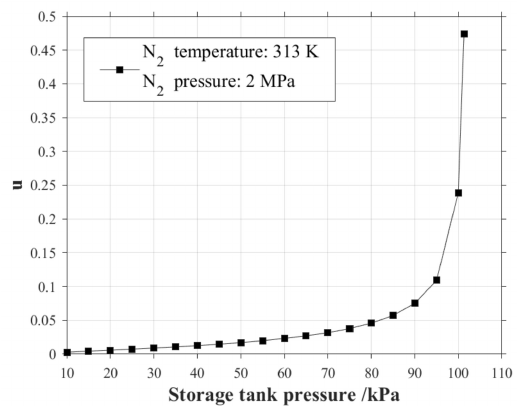
Figure 7. The variation of µ with the tank